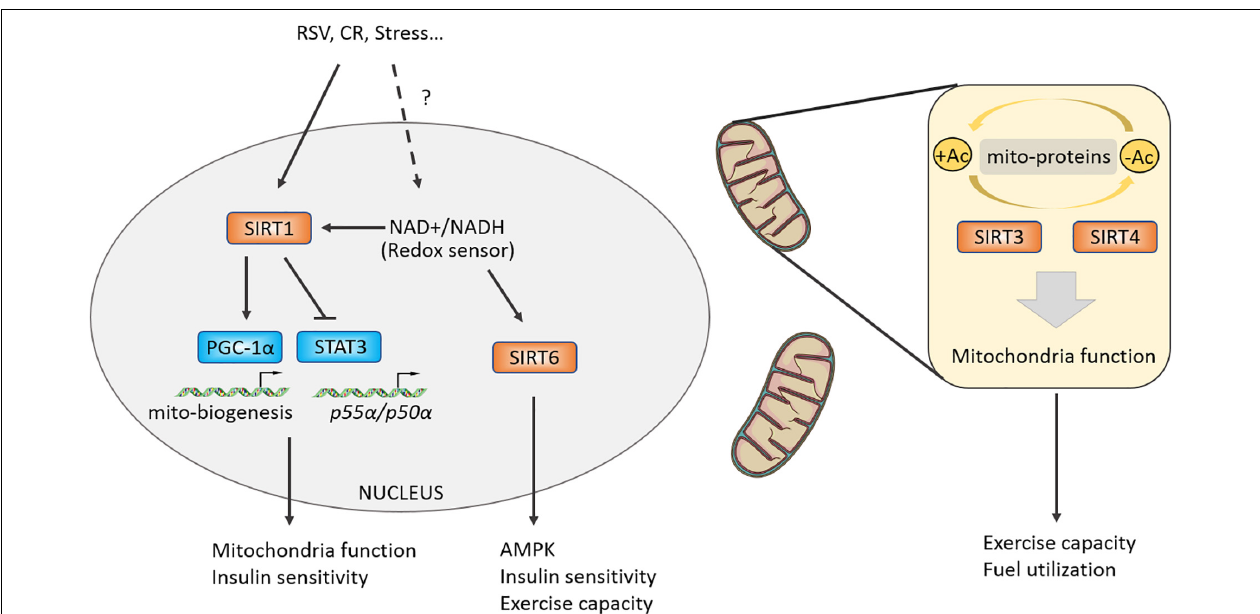
FIGURE 4 | Class III HDACs promote a stress-induced adaptation in muscle and regulate mitochondrial function. Class III HDACs are NAD + -dependent deacetylases and may function as a redox sensor in muscle cell. SIRT1 could activate PGC-1alpha by directly deacetylasing K13 site and regulate insulin sensitivity by targeting STAT3. Mitochondria-located Class III HDACs control mitochondrial function by deacetylating certain mitochondrial proteins, modulating muscle fuel utilization and exercise